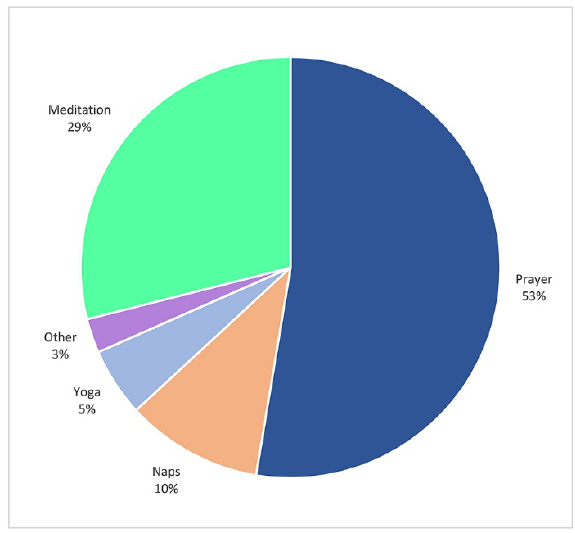
Figure 2 Use of the wellness and self-care